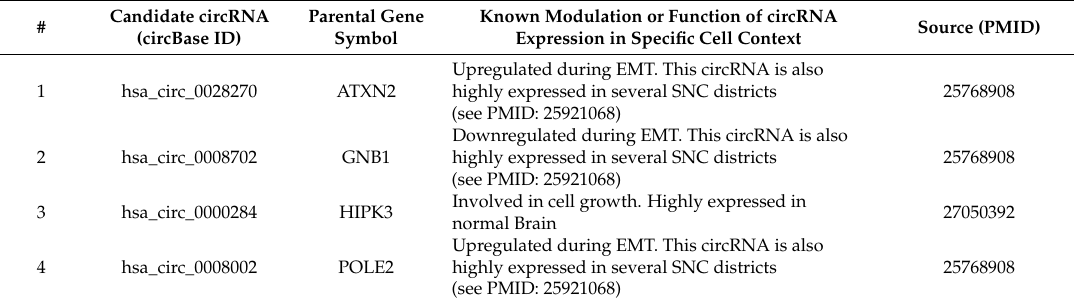
Table 2. Candidate